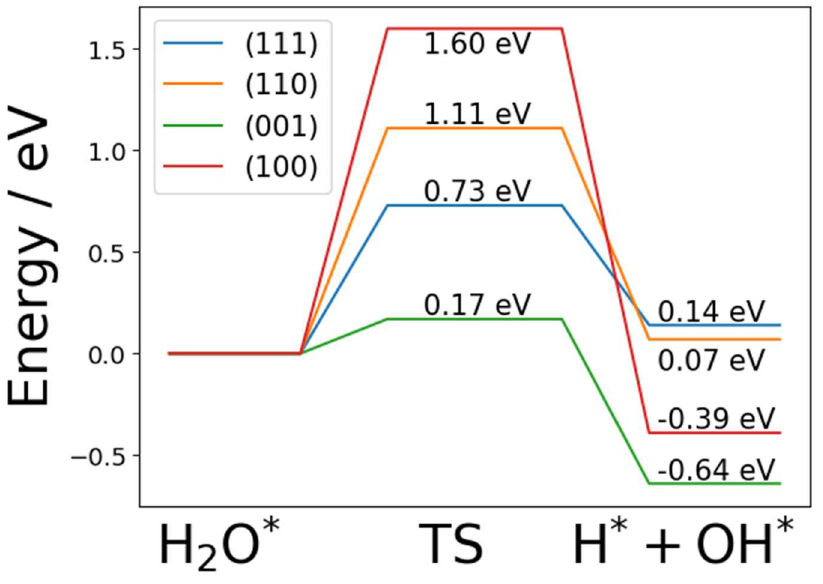
Figure 5. Reaction profile of the Volmer step (water dissociation) on Ni 3 N (111), (110), and (100) surfaces, showing the ZPE-corrected activation